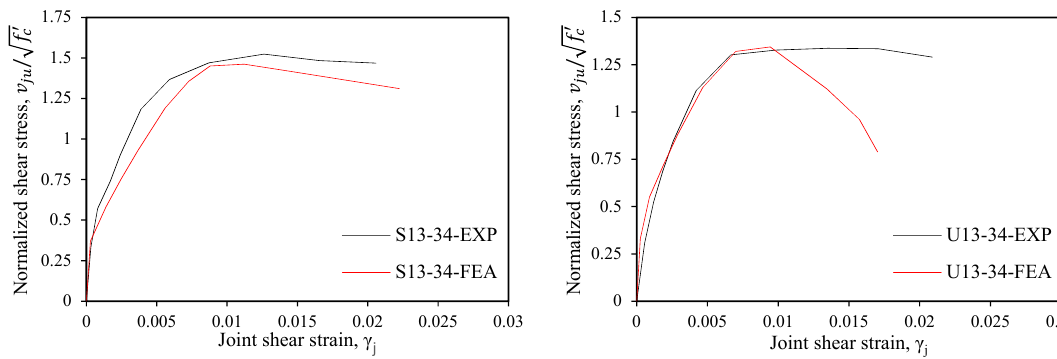
Figure 14. Envelope curves for the joint shear stress versus joint shear strain.